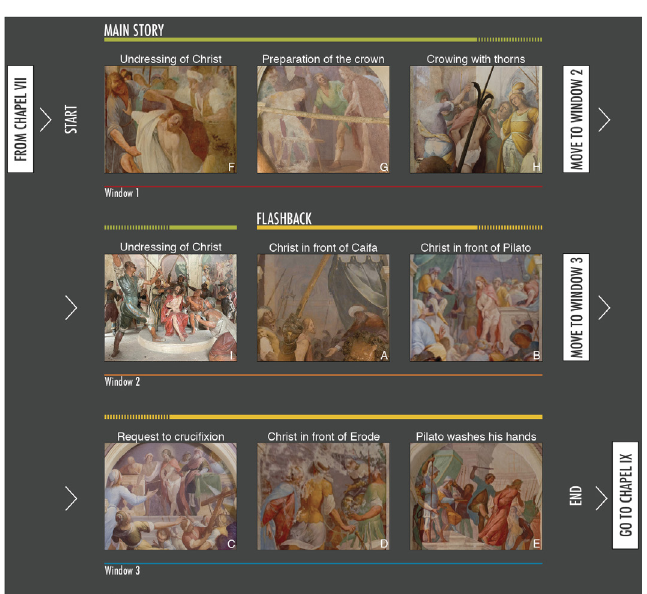
Fig. 12 Reading of the storyboard composed by the chapel’s frescos, highlighting the use of flashback technique.